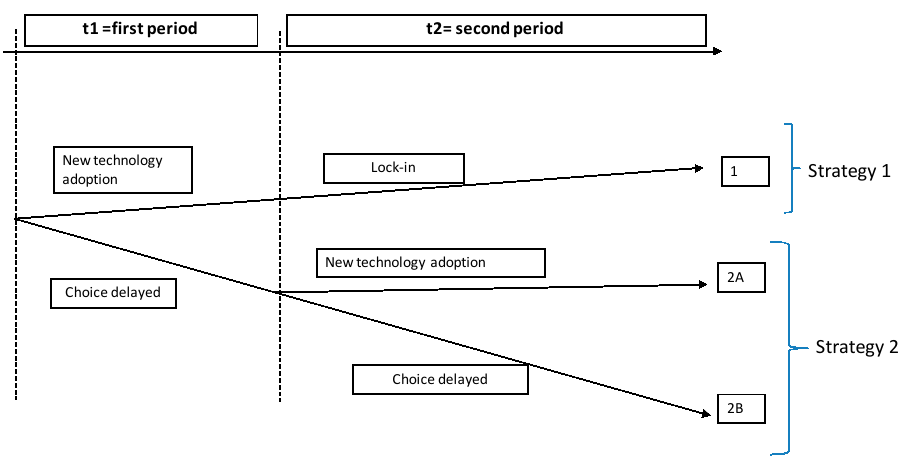
Figure 1. Timing of AMS